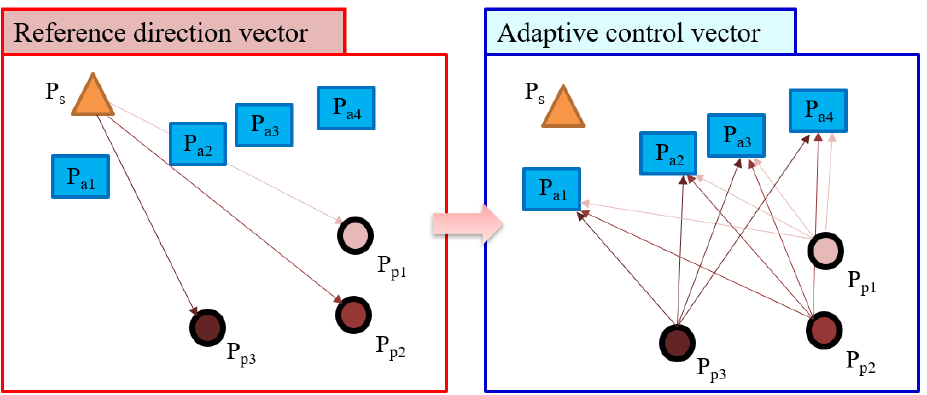
Figure 4. The gaze alignment approach of the teleported avatar using a reference direction in the left image and an adaptive control vector in the right image. The reference direction vector ( left ) is defined by the position of the sensor, P s , and the position of the participant in the MR tele-conference environment, P p . Here, P p1 , P p2 , and P p3 are the position of candidates where the participant can sit. The adaptive control vector ( right ) is defined by the position of the participant, P p , and the position of the teleported avatar, P a . Here, P a1 , P a2 , P a3 , and P a4 are the position of candidates where the tele- ported avatar can sit.